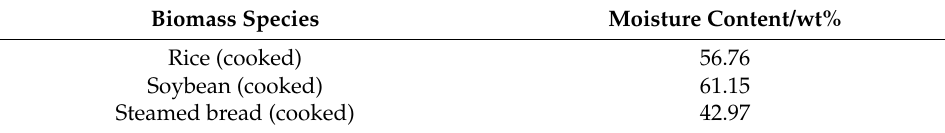
Table 2. Raw material moisture